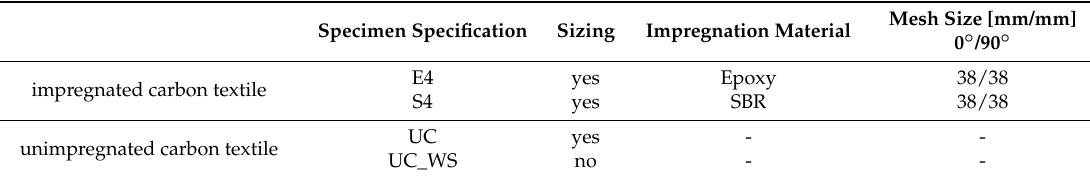
Table 1. Details of carbon textiles used in the investigations.